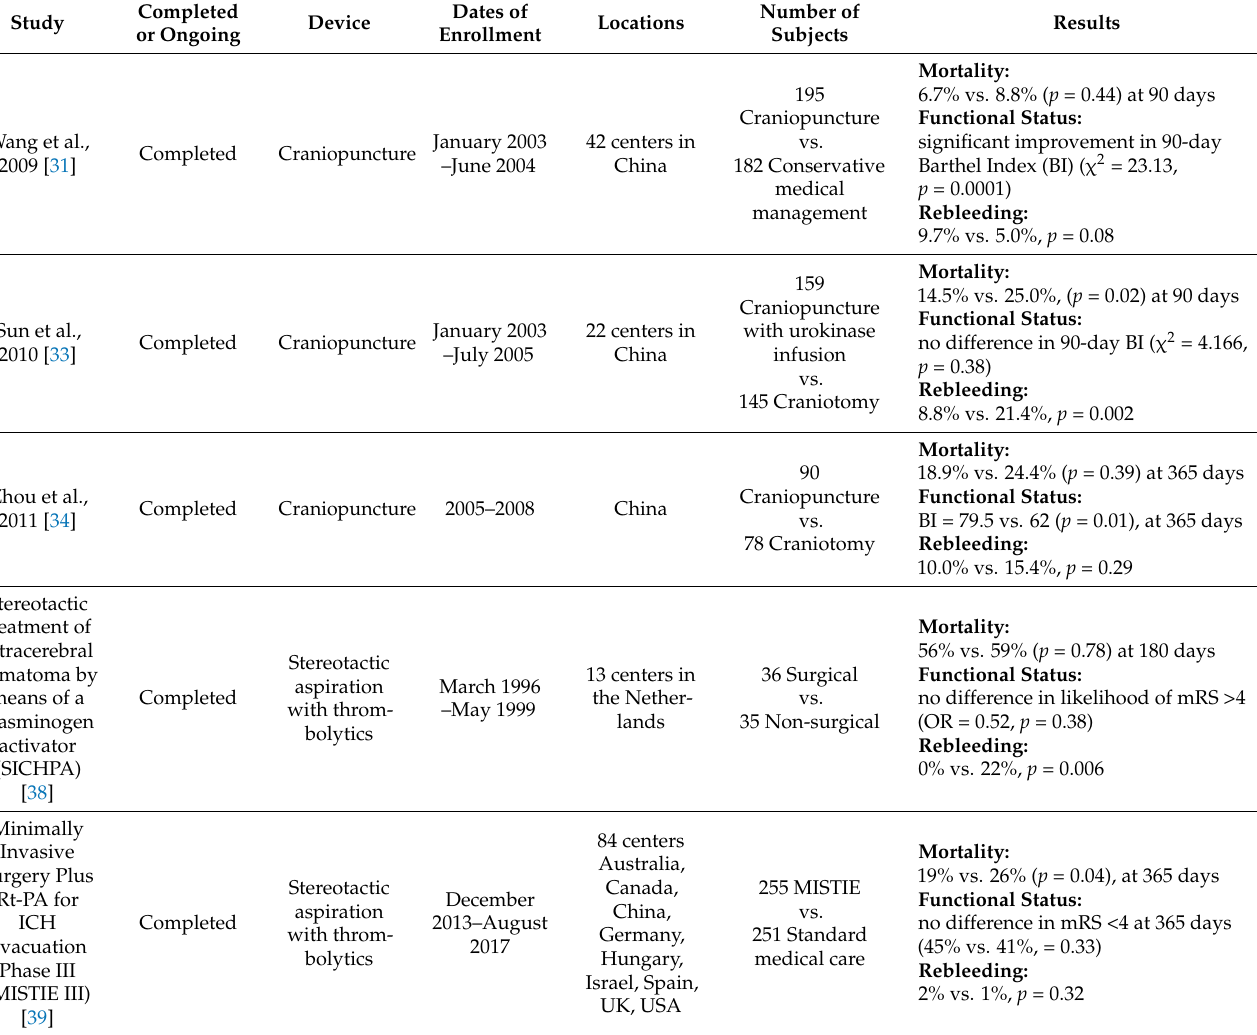
Table 1. Summary of major clinical trials for minimally invasive surgery for intracerebral hemorrhage evacuation techniques.